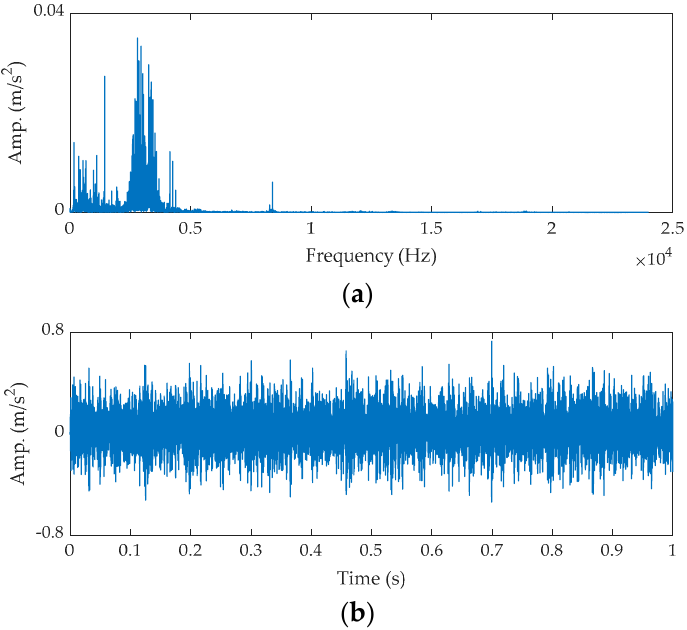
Figure 14. The test rig for the ball fault bearing. The time waveform of the raw signal and its FFT spectrum are shown in Figure 15.